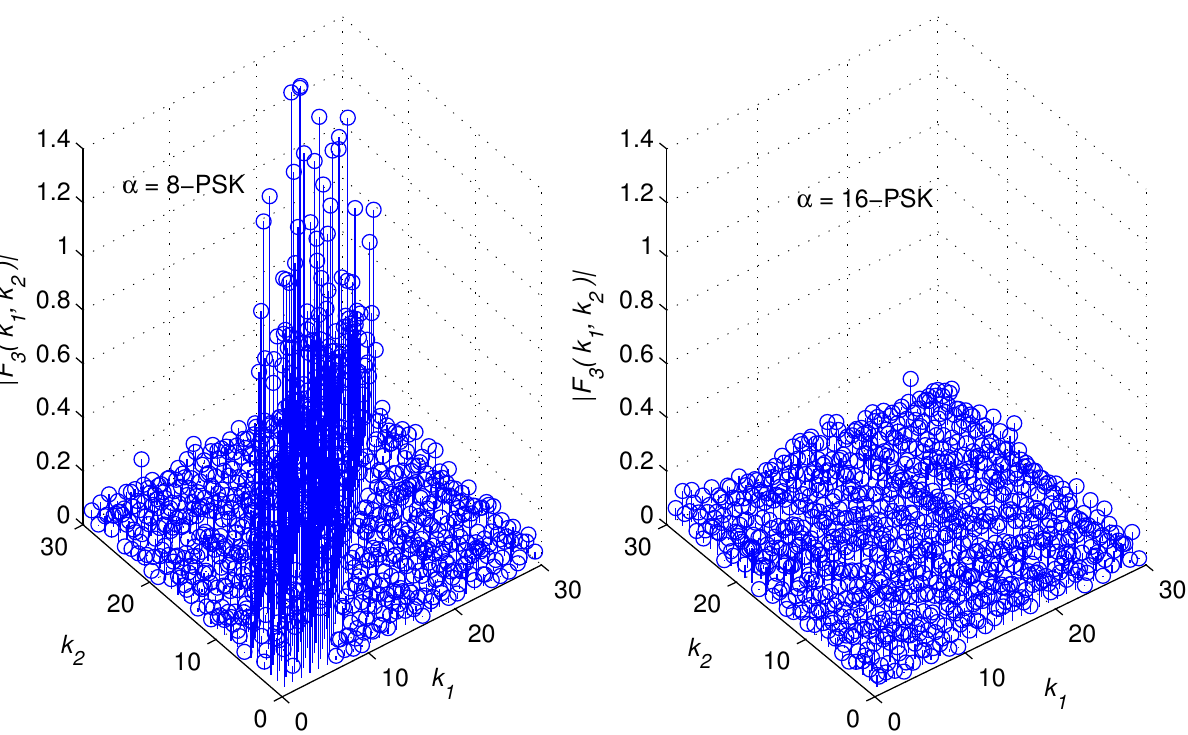
Figure 4. | F 3 ( k 1 , k 2 ) | for 8 − PSK and 16 − PSK